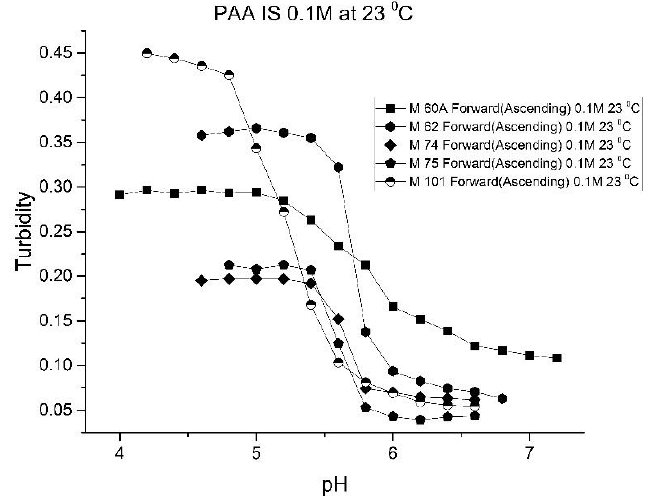
Figure 10. Ascending pH response curves for polymer particles of M-60A, M-62, M-74, M-75, and M-101 at 23 °C.